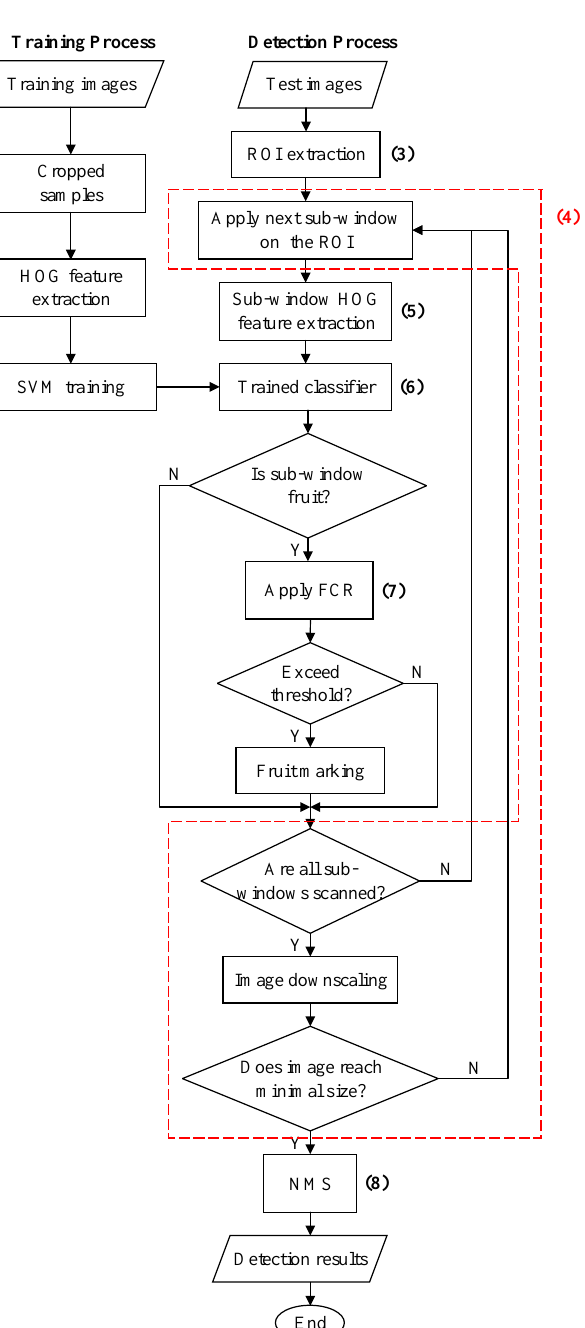
Figure 7. A flowchart of the developed algorithm: The numbers correspond to the steps described